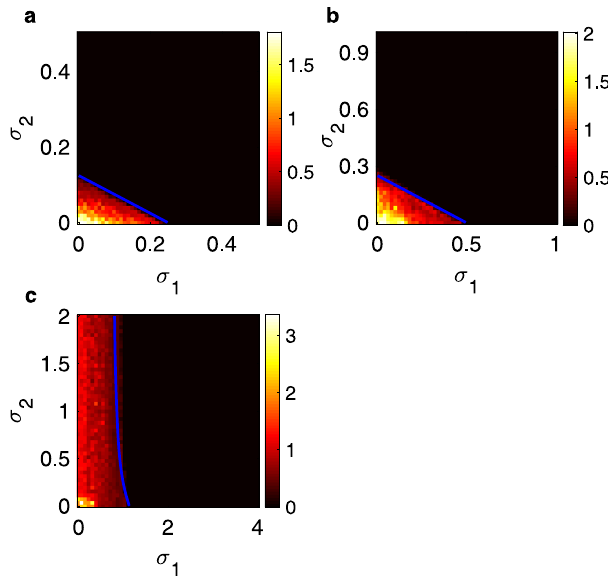
Fig. 2 Synchronization in simplicial complexeses of Hindmarsh – Rose neurons. Contour plots of the time averaged (over an observation time T = 500) synchronization error E (see “ Methods ” for de fi nition and the vertical bars of each panel for the color code) in the plane ( σ 1 , σ 2 ) for simplicial complexes of HR neurons coupled as in Eq. (19). Parameters are fi xed in the chaotic regime ( r = 0.006, s = 4, I = 3.2). a – c refer to three different simplicial complexes corresponding to the structures considered in Fig. 1a – c. The blue continuous lines are the theoretical predictions of the synchronization thresholds obtained from Eq.